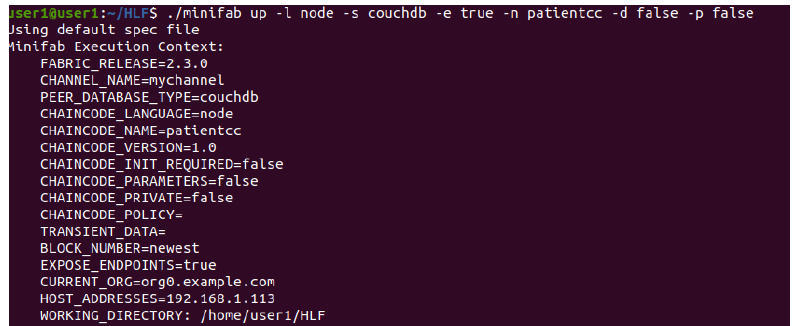
Figure 5. Smart contract installation information.